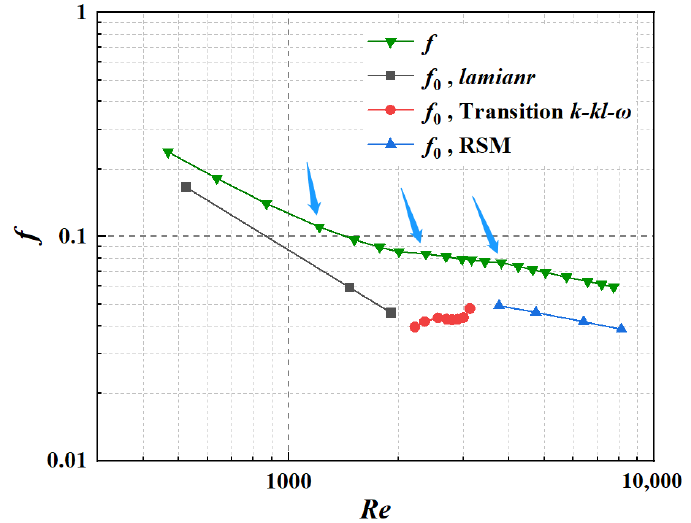
Figure 20. Variation in friction factor with Reynolds number.